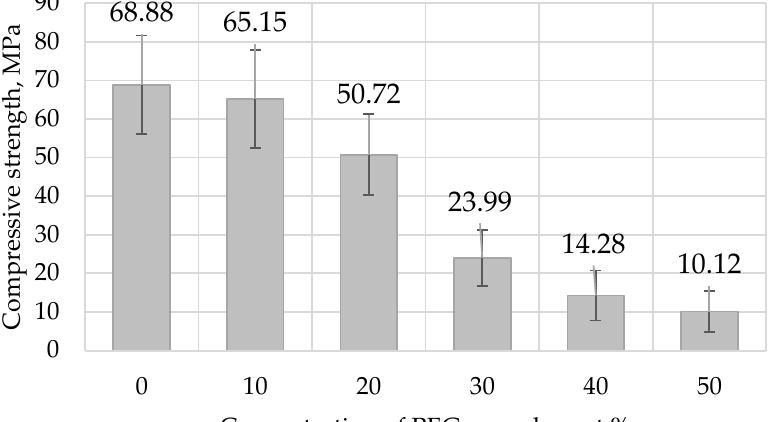
Figure 7. Mechanical strength of ceramics.